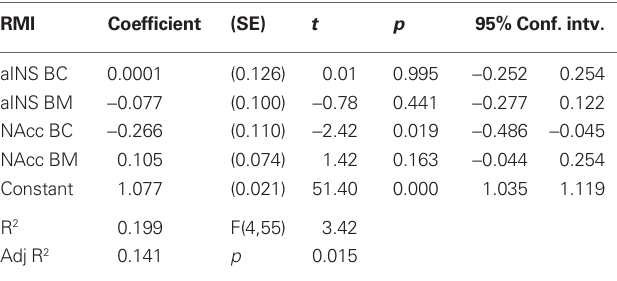
Table 3 | NAcc BOLD signal predicts motivational index across